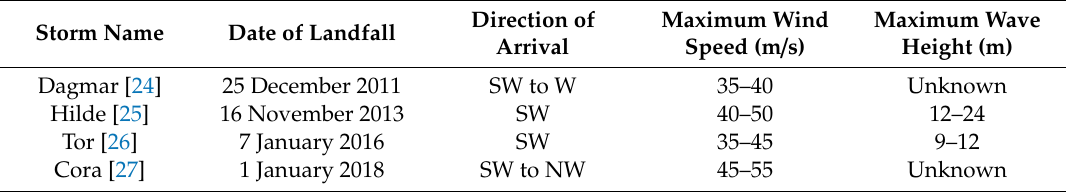
Table 2. Impact of superstorms in the North Trondelag and Nordland districts of coastal Norway summarized from reports issued by the Norwegian Meteorological